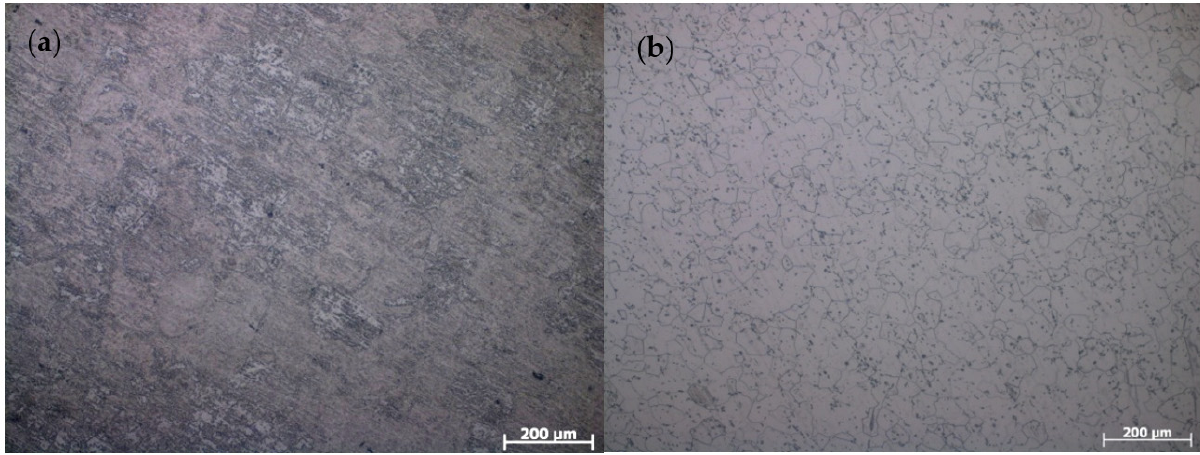
Figure 2. Microstructure of SLM alloy and wrought TiNi. ( a ) SLM alloy; ( b ) Wrought TiNi.